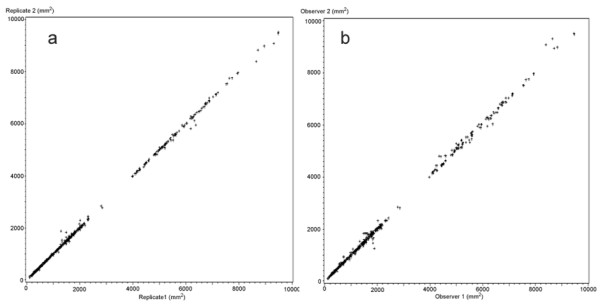
CSA in mm2 for all measured muscles. a) Intra-observer comparison, replicate 1 against replicate 2 both observers combined. (n = 744) and b) Inter-observer comparison, observer 1 against observer 2, both replicates combined (n = 744).